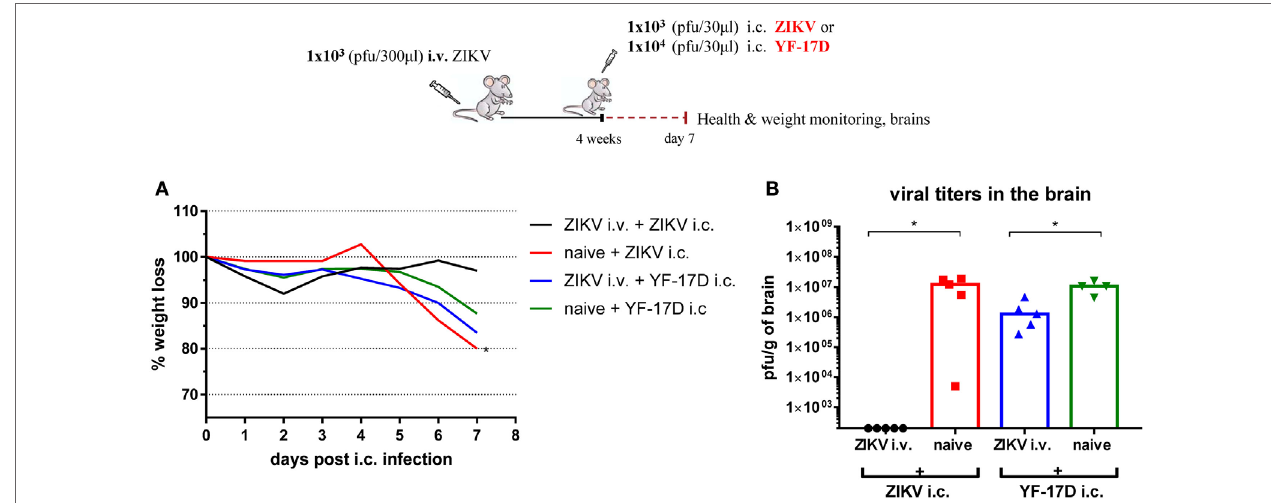
FigUre 8 | The induced protection is virus-specific. Wild-type C57BL/6 mice were inoculated with 1 × 10 3 pfu Zika virus (ZIKV) i.v. and 4 weeks later were challenged i.c. with either 1 × 10 3 pfu ZIKV or 1 × 10 4 pfu YF-17D. Mice were weighed and monitored daily (a) , and on day 7 post i.c. challenge, brains were removed and viral titers were measured by a plaque assay (B) . Groups of naïve mice were used as negative controls. The detection limit for virus in the brain was 250 pfu/g organ for both viruses. Each dot represents an individual animal, and bars represent the medians of the groups. The weight curves depict the group medians. n = 4–5 mice/group, * p < 0.05, mice challenged with the same virus are compared. The results of one of two identical experiments are depicted.